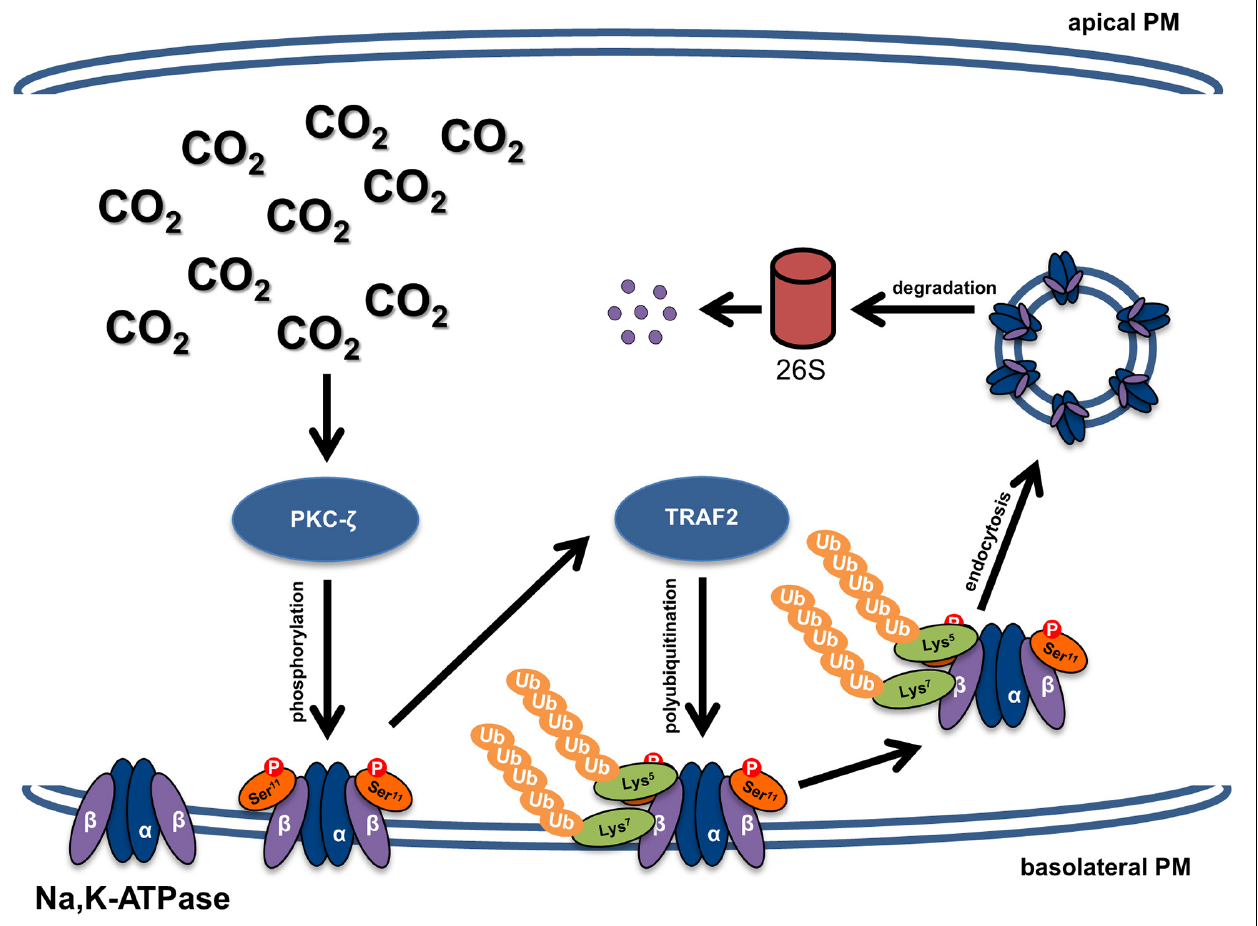
FIGURE 6 | Schematic representation of the mechanism of hypercapnia-induced downregulation of the Na,K-ATPase β -subunit and impaired alveolar epithelial barrier integrity. Elevated CO 2 levels lead to activation of PKC- ζ , which phosphorylates the Na,K-ATPase β -subunit at serine 11, thereby making the protein a target of polyubiquitination at lysine residues 5 and 7 by TRAF2. Polyubiquitination of the Na,K-ATPase β -subunit promotes internalization of the protein from the plasma membrane and subsequent proteasomal degradation, which impairs the junctional function of the Na,K-ATPase β -subunit and thus leads to alveolar epithelial barrier